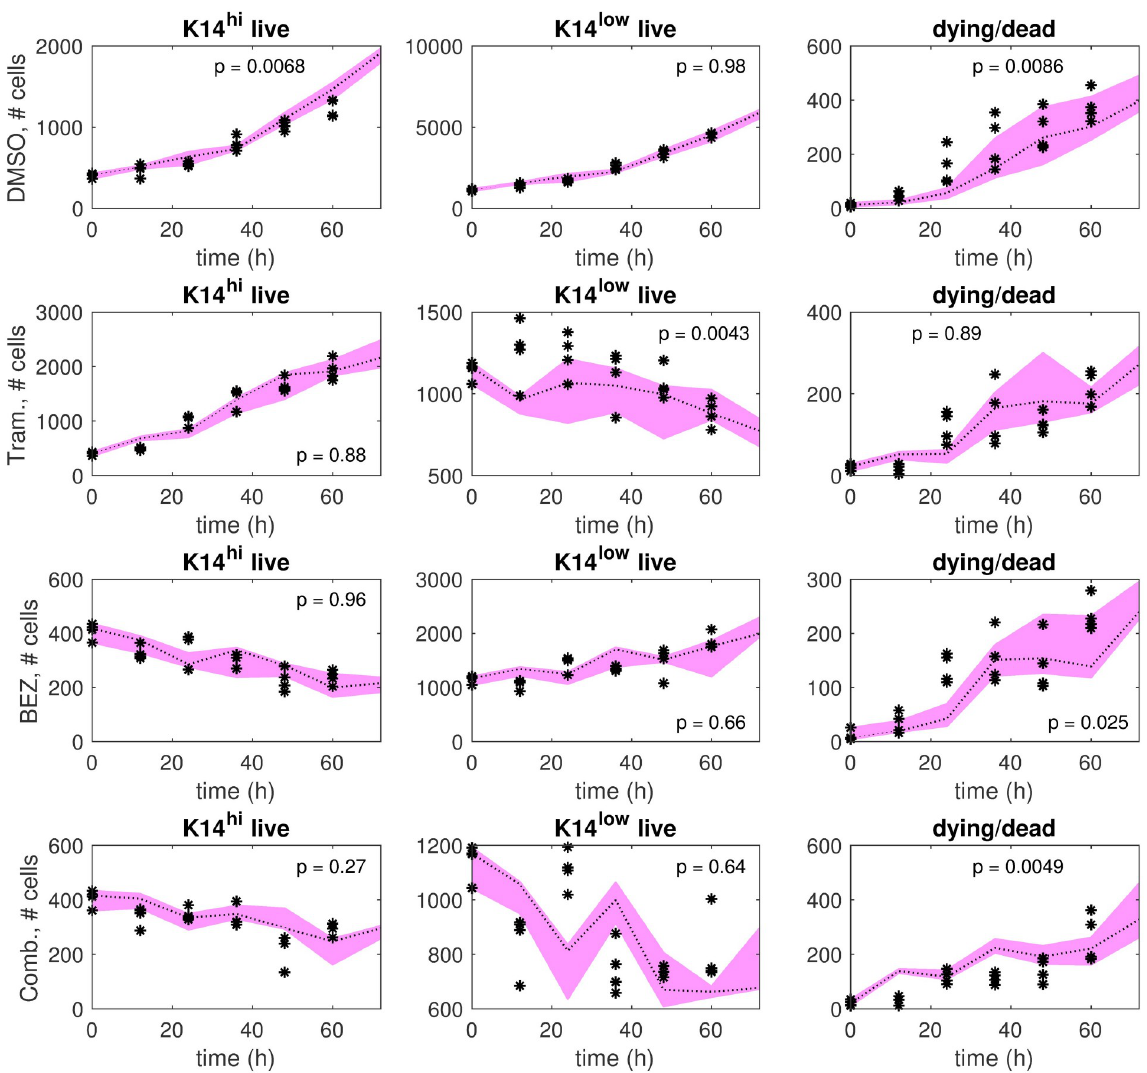
Fig 9. Single model predictions in comparison to test data, where the differentiation states are defined by K14 only. The test samples (black stars) and single model predictions (pink bands) are shown for each treatment condition: DMSO (row 1), Trametinib (row 2), BEZ235 (row 3), and Trametinib+BEZ235 (row 4). The single model was identified on the training data using K14 hi and K14 low as the differentiation states for each treatment condition. The pink band extends between the maximum prediction and the minimum prediction out of four predictions in total at each time point (0h, 12h, ... , 72h). The dotted line indicates the median of the predictions. Higher p-values indicate better consistency between predictions and test data over the time horizon (12h, 24h, ... ,